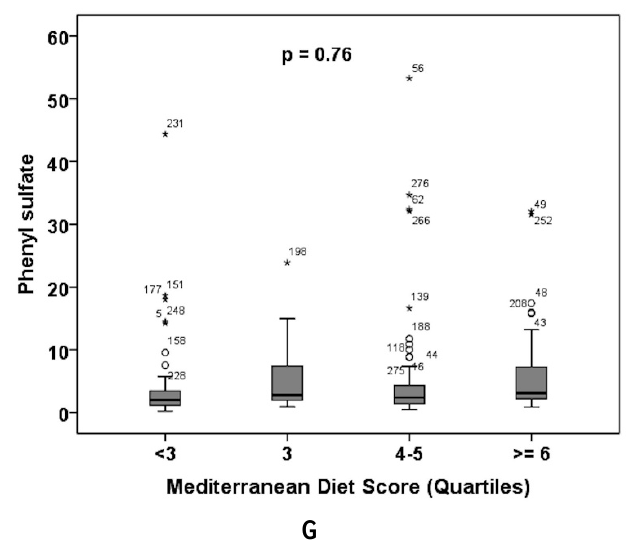
Figure 2. Carotid plaque burden is related to plasma levels of the intestinal metabolites. All the plasma levels are in µmol/L. TPA = total plaque area (mm 2 ). ( A ) Trimethylamine N-oxide; ( B ) p-cresyl sulfate; ( C ) hippuric acid; ( D ) indoxyl sulfate; ( E ) p-cresyl glucuronide; ( F ) phenyl acetyl glutamine; and ( G )